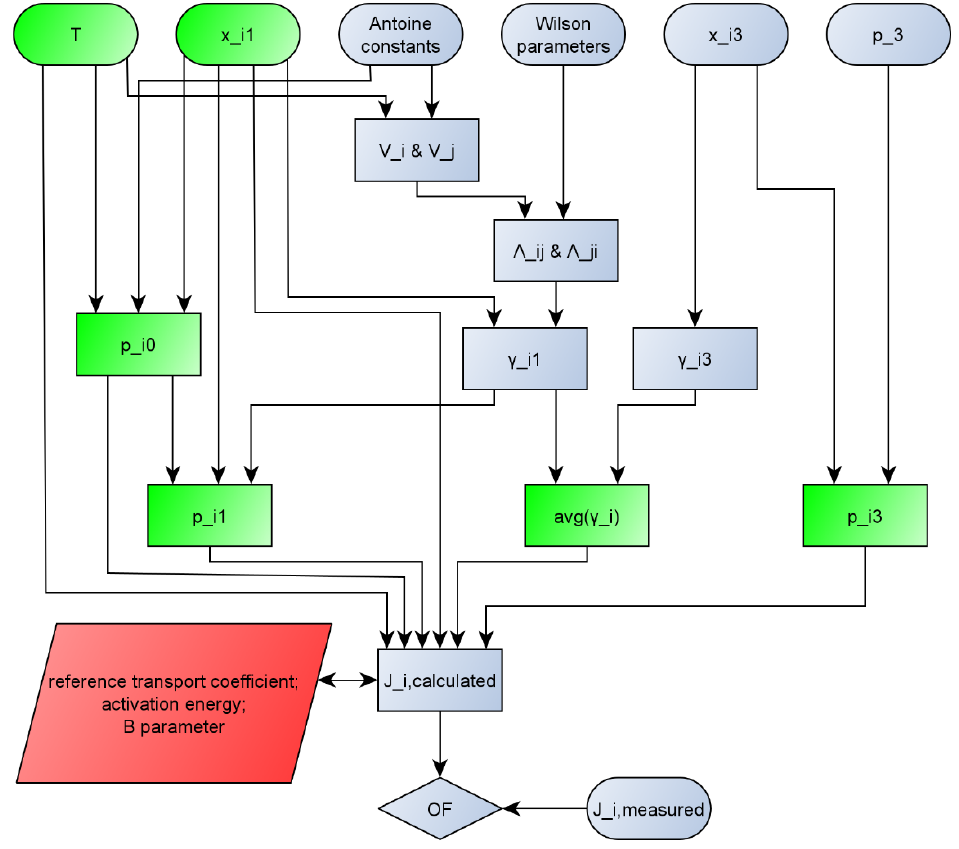
Figure 1. Flowchart of calculation of pervaporation modelling. (Interpretation: p_i0 means p i0 , others can be interpreted the same way and avg(y_i) means γ i . Green parameters are the inputs of STATISTICA software. Red parameters are the parameters estimated by STATISTICA software.)